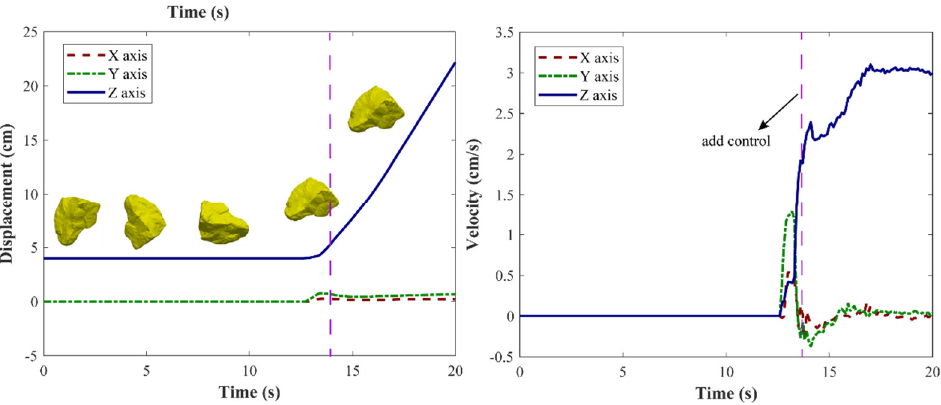
Figure 10. The position and velocity variations of the mass center of the debris.